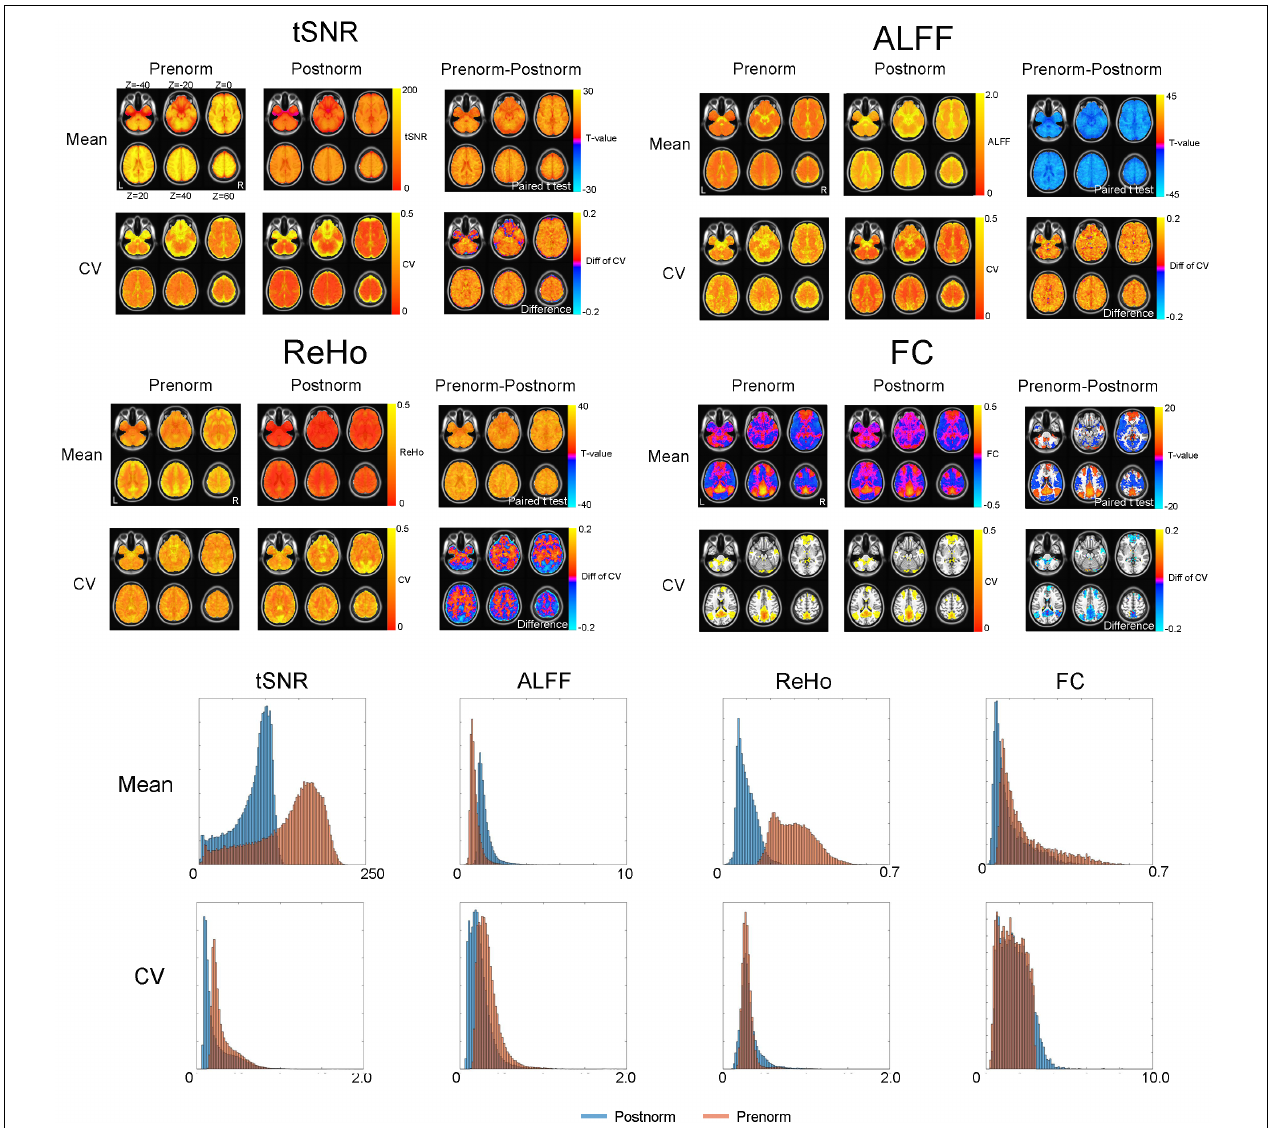
FIGURE 2 | Effect of normalization strategies on temporal signal-to-noise ratio (tSNR), amplitude of low-frequency fluctuation (ALFF), regional homogeneity (ReHo), and seed-based functional connectivity (FC) of empirical images. The group mean maps of four rs-fMRI indices including tSNR, ALFF, ReHo, and seed-based FC [seed coordinate (–5, –49, 40)] were shown for both normalization strategies. A paired t -test (GRF corrected, voxel p < 0.01, cluster p < 0.05) was utilized to compare them between Prenorm and Postnorm. The coefficient of variation (CV) of each index under each normalization strategy was also shown and compared by the difference map. For FC, given that a lot of regions have negative or very small FC values, CV is not well defined, therefore we only show the CV within a default mode network (DMN) mask and the histogram for FC is within the DMN mask. The bottom part showed the histogram of tSNR, ALFF, ReHo, and FC as well as their CV for both normalization strategies. Again, the histograms of tSNR, ALFF, and ReHo were for whole brain, but the histogram of FC is for the DMN